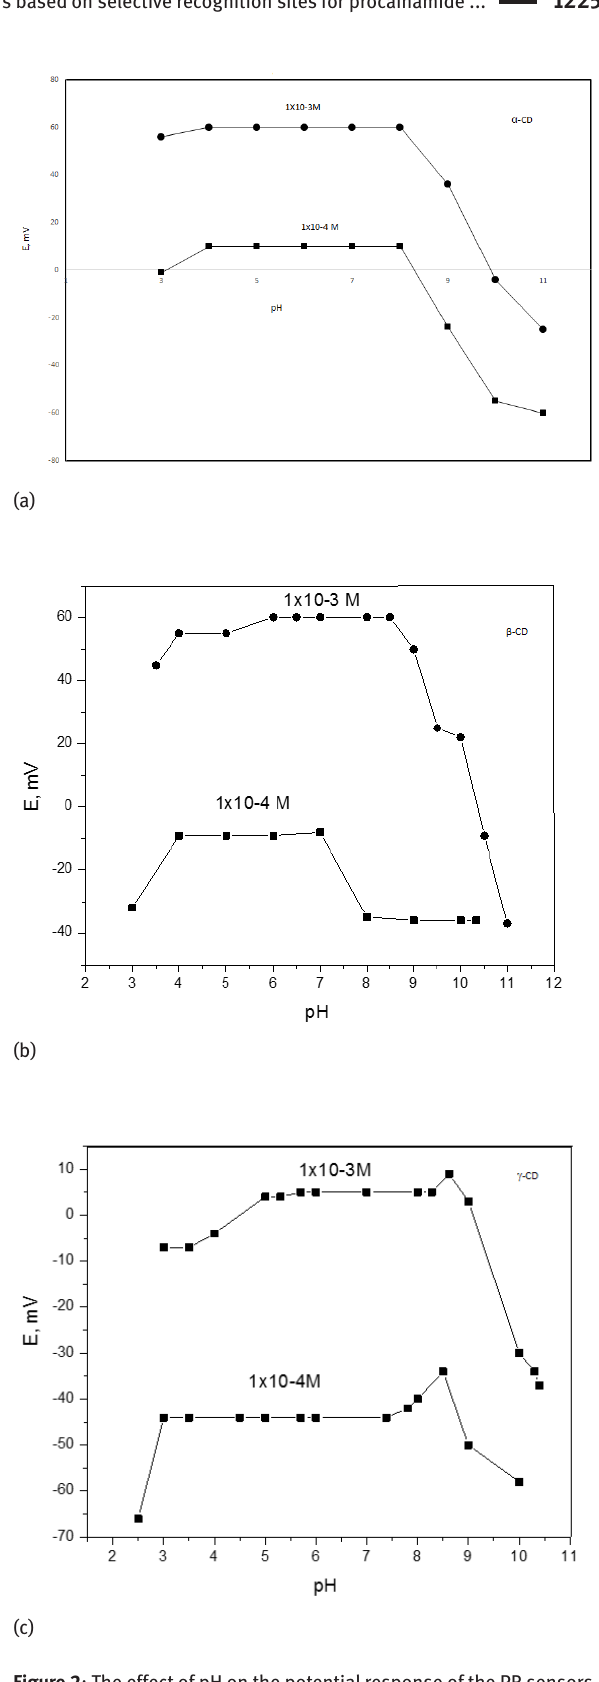
Figure 2 : The effect of pH on the potential response of the PR